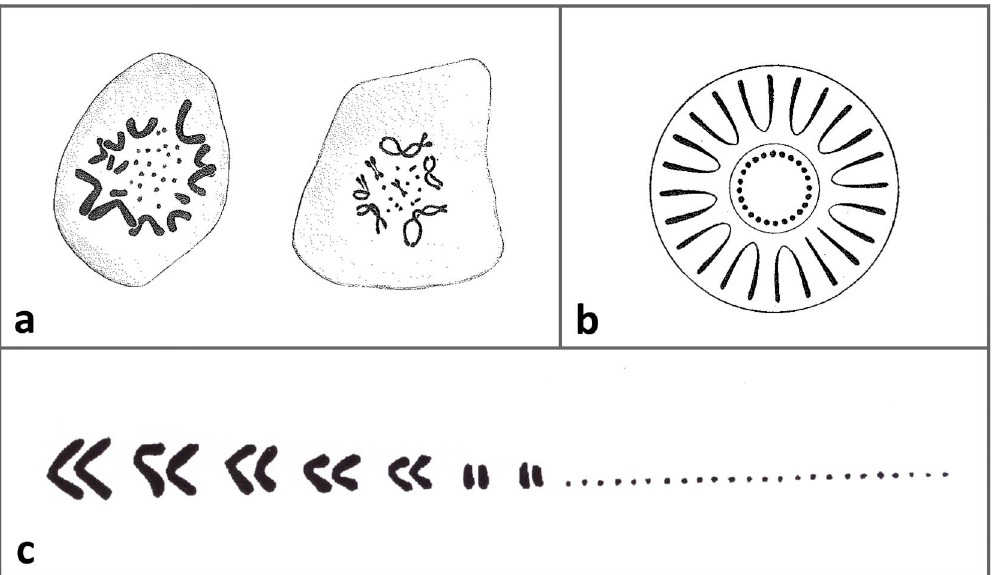
Figure 1. Reprint of the idealized drawings of two examples of male metaphases (a), the schematic depiction of metaphase (b) from Matthey (1931), and the karyotype (c) from Matthey (1933) of the Gila monster.